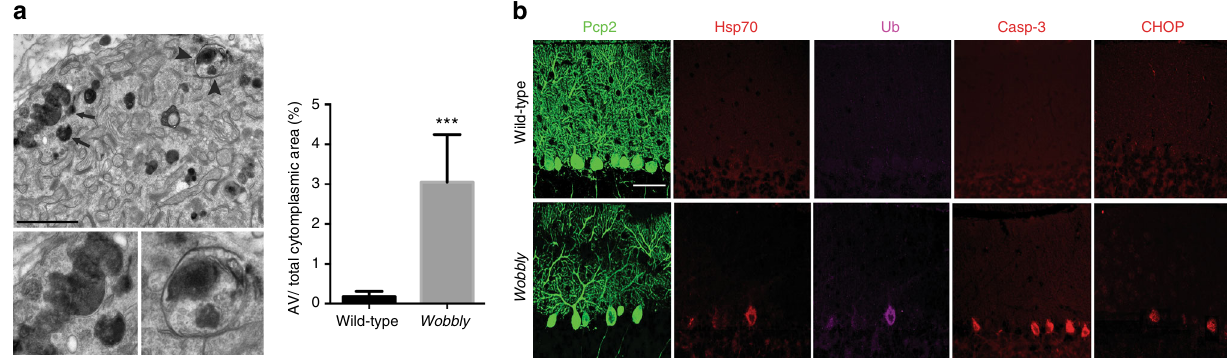
Fig. 5 Protein misfolding and ER-stress-induced apoptosis in wobbly PNs. a Electron micrographs and quanti fi cation of autophagic vacuoles (AV) in wobbly PNs at P40. Arrows indicate electron-dense protein aggregates and arrowheads point to protein aggregates in autophagic bodies, both are magni fi ed in the lower panel ( n = 3 animals per genotype; n = 5 cells per animal; representative images are shown). Statistical evaluation: two-tailed t test. Statistically signi fi cant difference is indicated ( *** P ≤ 0.001). Data represent mean ± SEM. b Immuno fl uorescence with antibodies to Pcp2, Hsp70, ubiquitin (Ub), caspase-3 (Casp-3), and CHOP on P40 wild-type and wobbly cerebella ( n = 5 for each of the genotypes; representative images are shown). Scale bars: